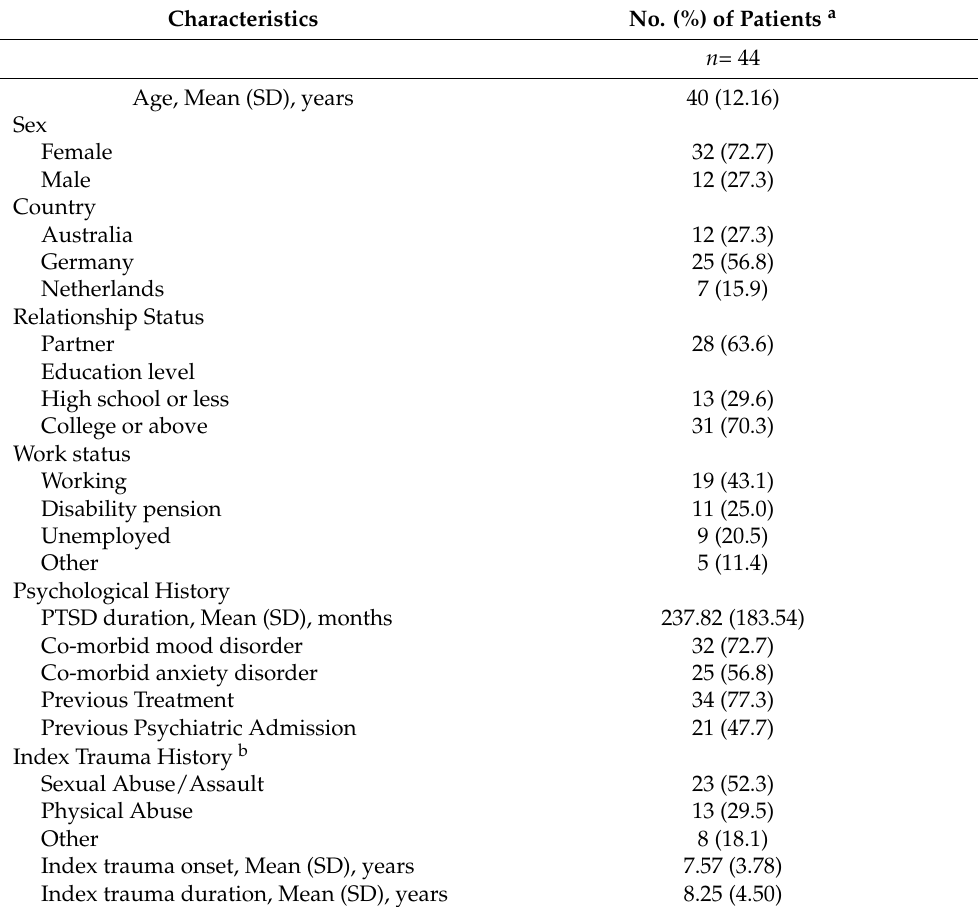
Table 1. Demographic information and characteristics of IREM patients.